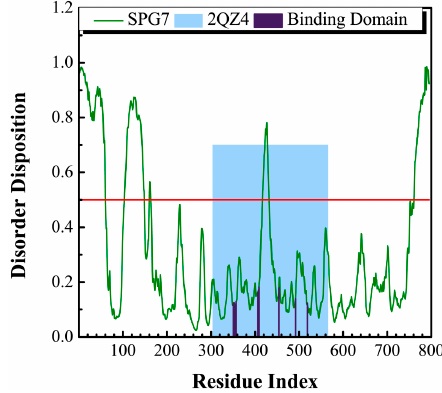
Figure 1. Disordered disposition for amino acids of paraplegin predicted by PONDR-Fit.